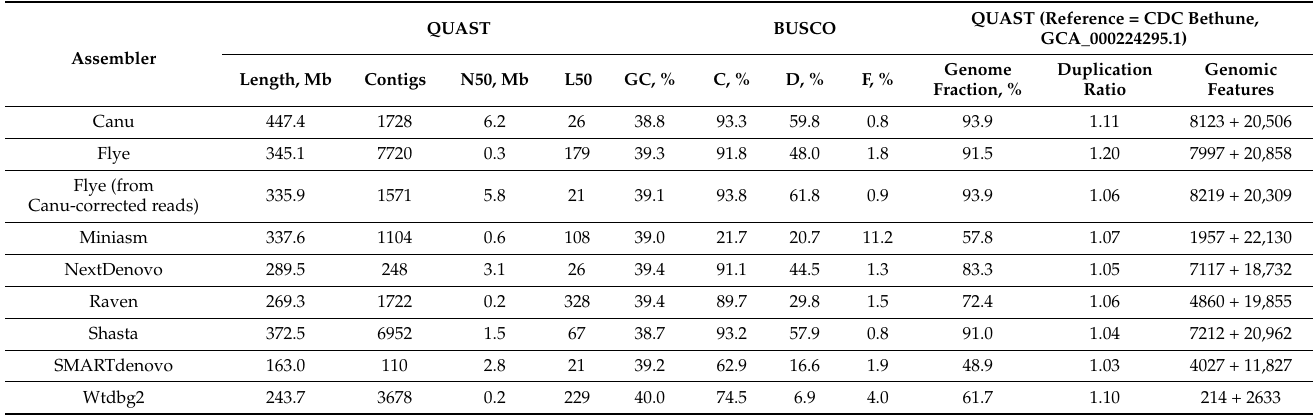
Table 1. QUAST and BUSCO statistics for the raw genome assemblies of L. usitatissimum line 3896 (computed relative to the CDC Bethune assembly and